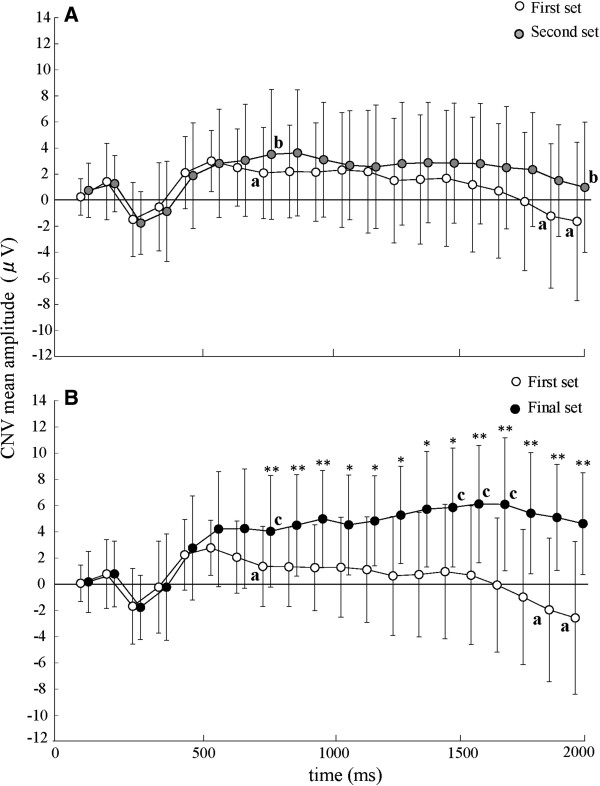
Means and standard deviations of mean amplitudes for every 100-ms period of CNV between S1 and S2. (A) Comparison between the first (white circle) and second (gray circle) sets for 15 subjects; (B) Comparison between the first (white circle) and final (black circle) sets for 13 subjects. The asterisk indicates a significant increase on a trial in the final set compared with the first set (*: P <0.05, **: P <0.01). ‘a’ and ‘b’ indicate a significant decrease from the 700–800 ms period after S1 and ‘c’ indicates a significant increase from that, respectively.